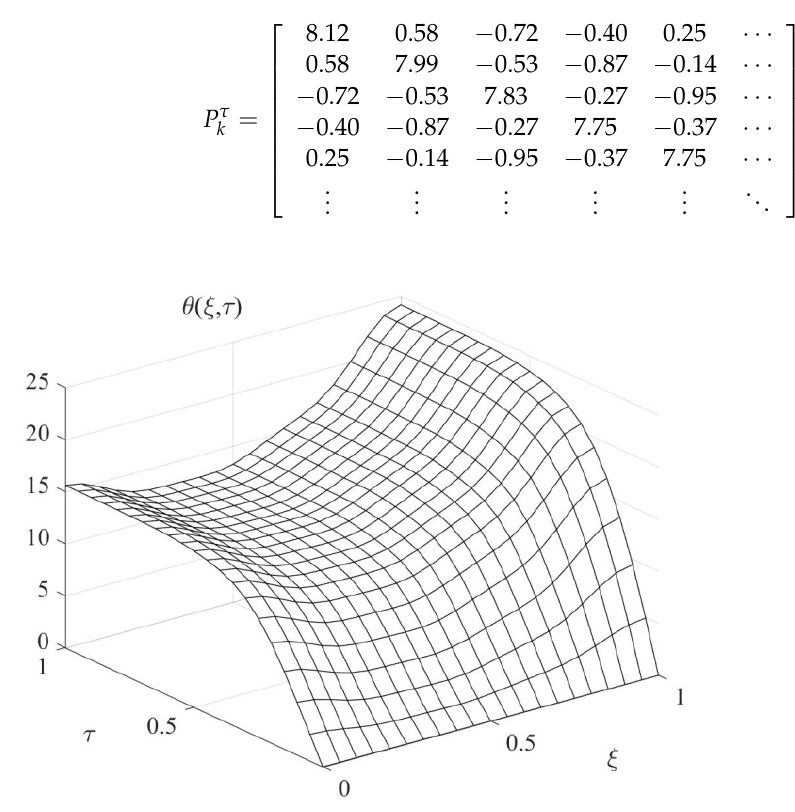
Figure 2. Temperature distribution graph is case of constant α . The simulation results for n 1 = n 2 = 7 and variable heat transfer coefficient are shown in Figure 3.